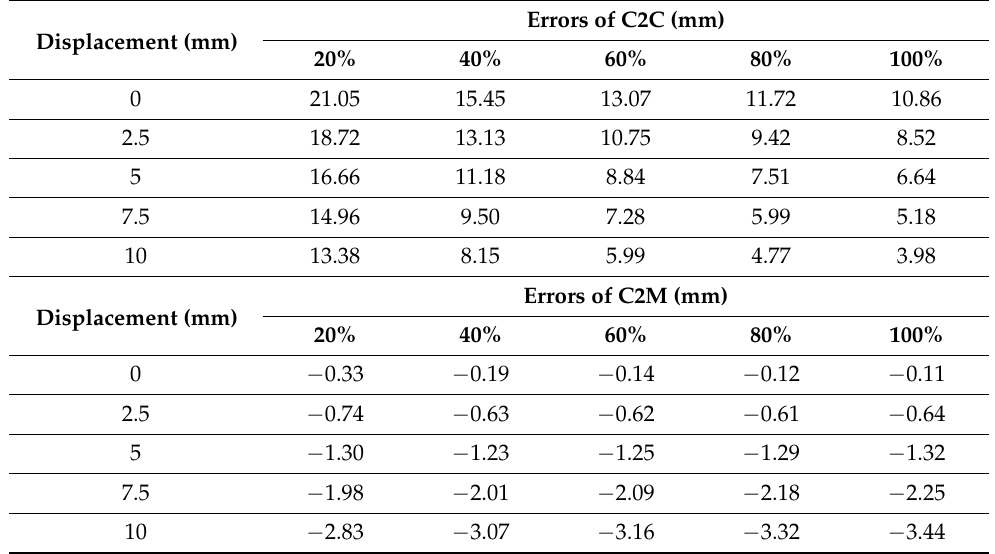
Figure 13. Displacement estimation in SMW, ( a ) Displacement calculated by C2C, ( b ) Displacement calculated by C2M, ( c ) Displacement calculated by M3C2. Table 2. Displacement errors of C2C, C2M, and M3C2 in